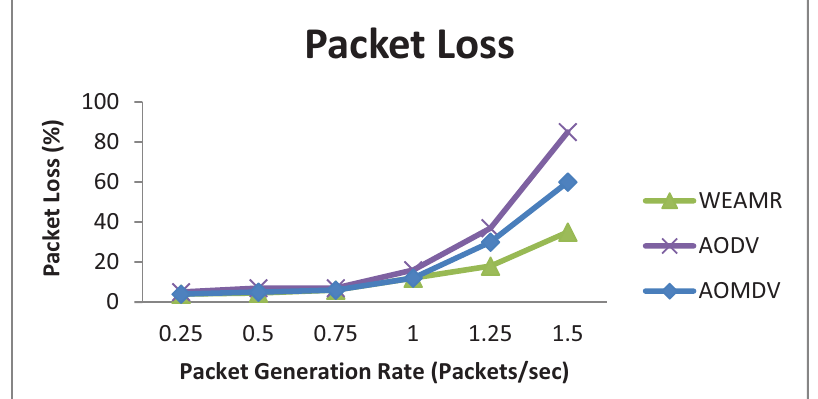
Figure 15. Average packet loss in end to end communication with increasing number of